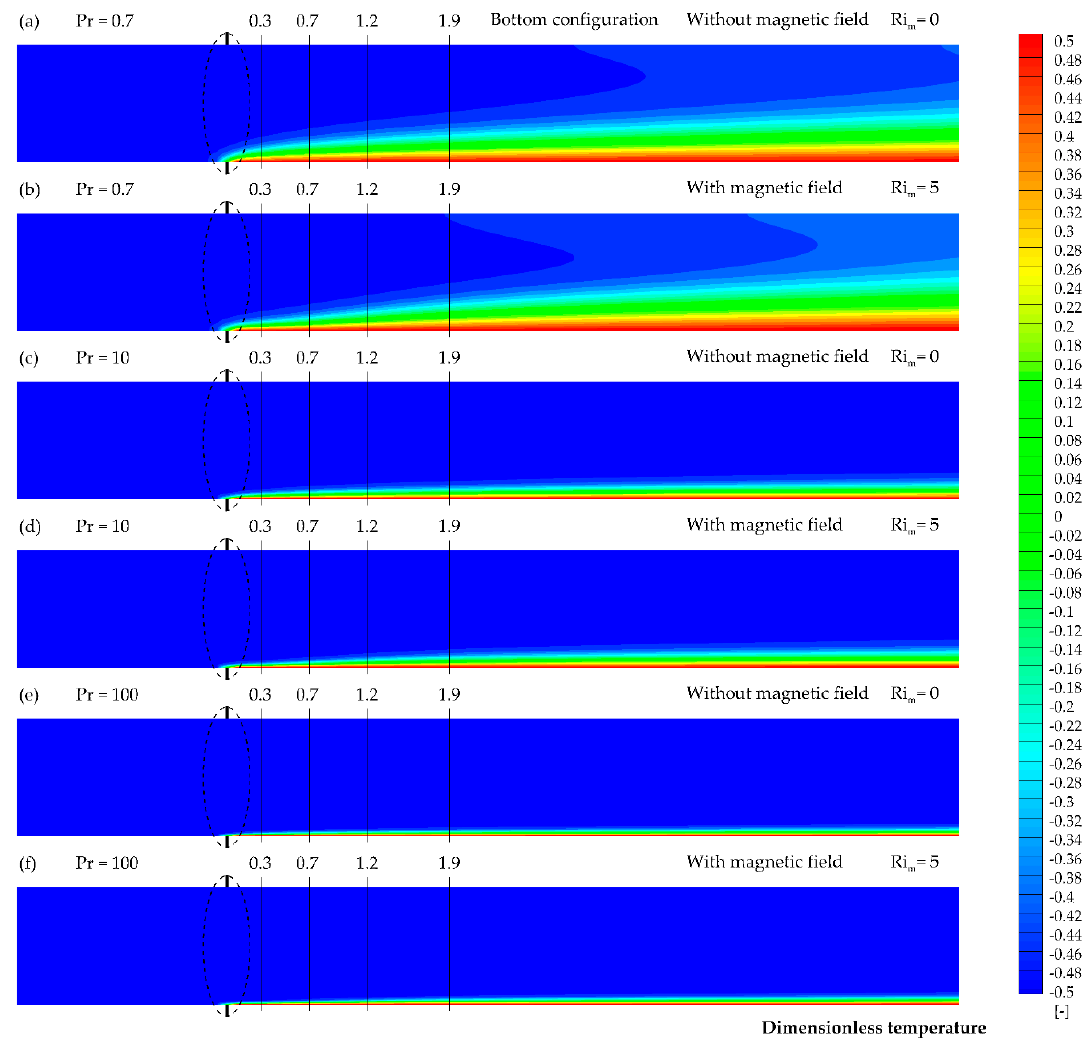
Figure 4. Dimensionless temperature distribution in the axial cross-section for bottom configuration: ( a ) Pr = 0.7 and Ri m = 0, ( b ) Pr = 0.7 and Ri m = 5, ( c ) Pr = 10 and Ri m = 0, ( d ) Pr = 10 and Ri m = 5, ( e ) Pr = 100 and Ri m = 0, ( f ) Pr = 100 and Ri m = 5.